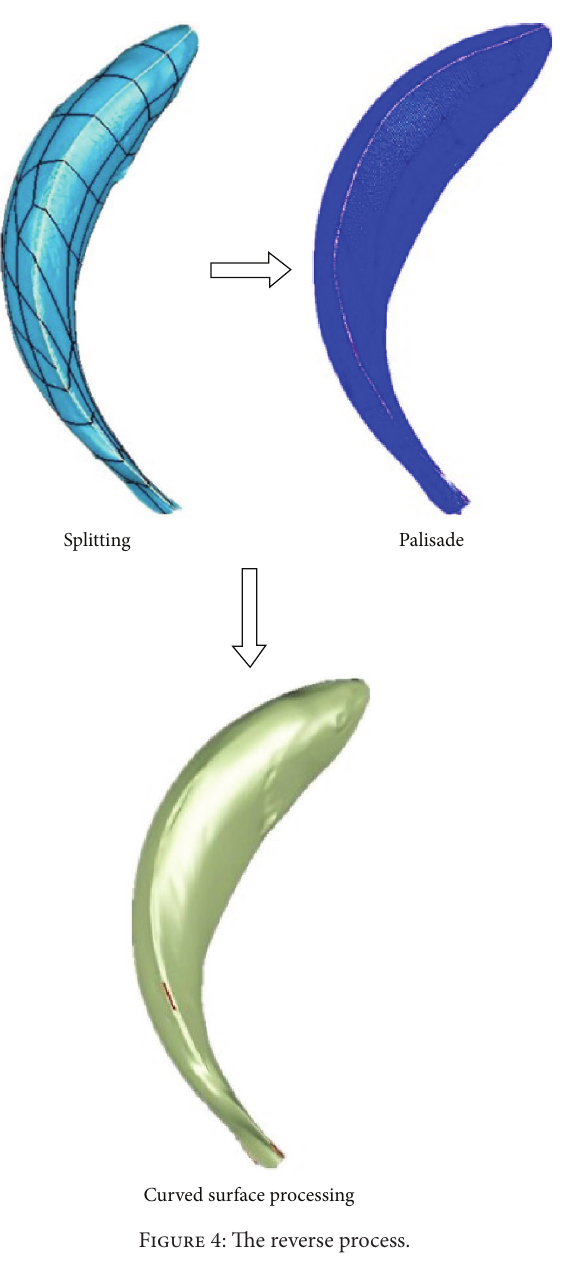
Figure 4: The reverse process.